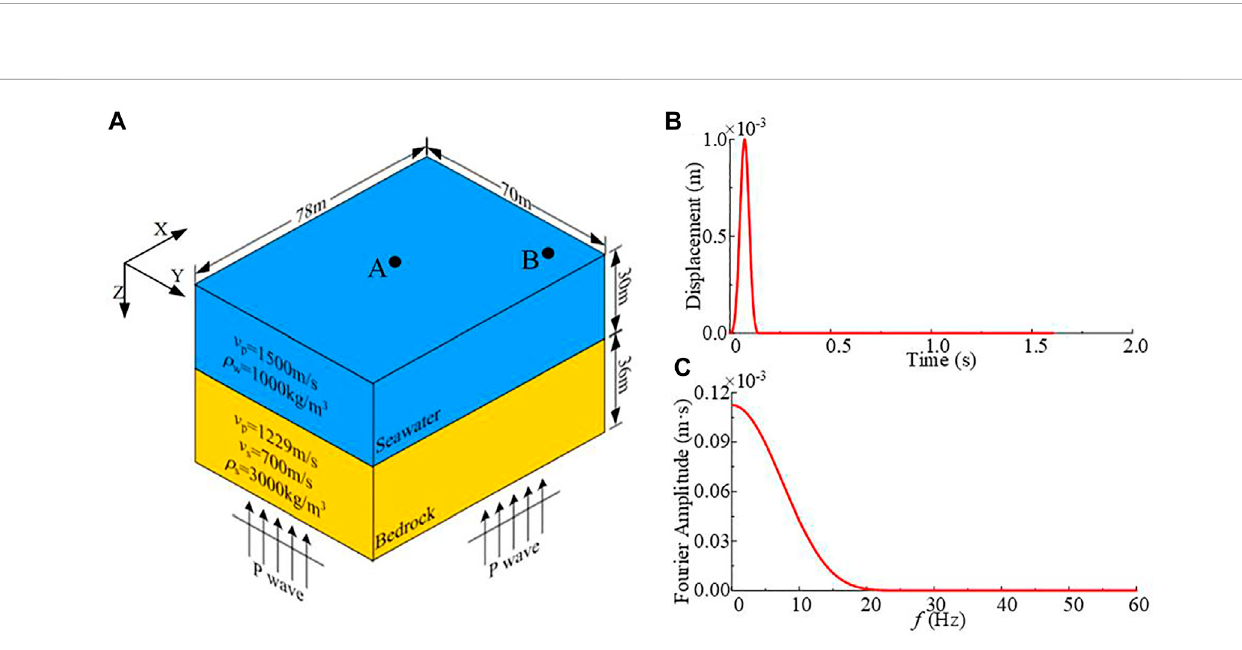
FIGURE 4 The computational model and the input pulse wave (A) Schematic diagram of horizontal layered computational model; (B) Displacement time history of the input wave; (C) Displacement Fourier amplitude spectrum of the input